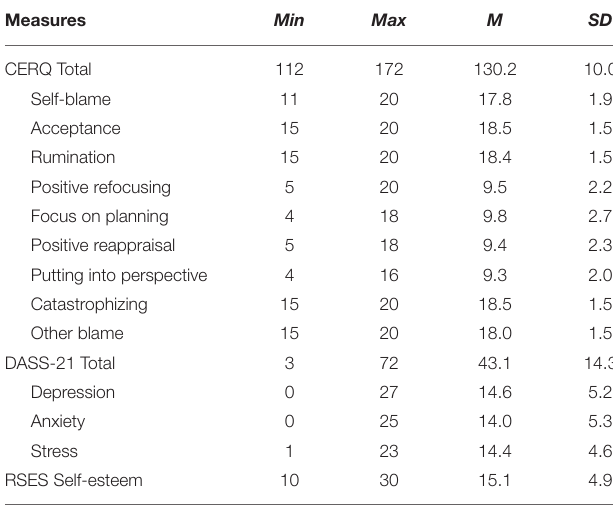
TABLE 1 | Descriptive statistics for the Cognitive Emotion Regulation Questionnaire (CERQ) and its subscales, the Depression Anxiety and Stress Scale, Short Form (DASS-21) and its subscales, and the Rosenberg Self-esteem Scale (RSES) ( N =